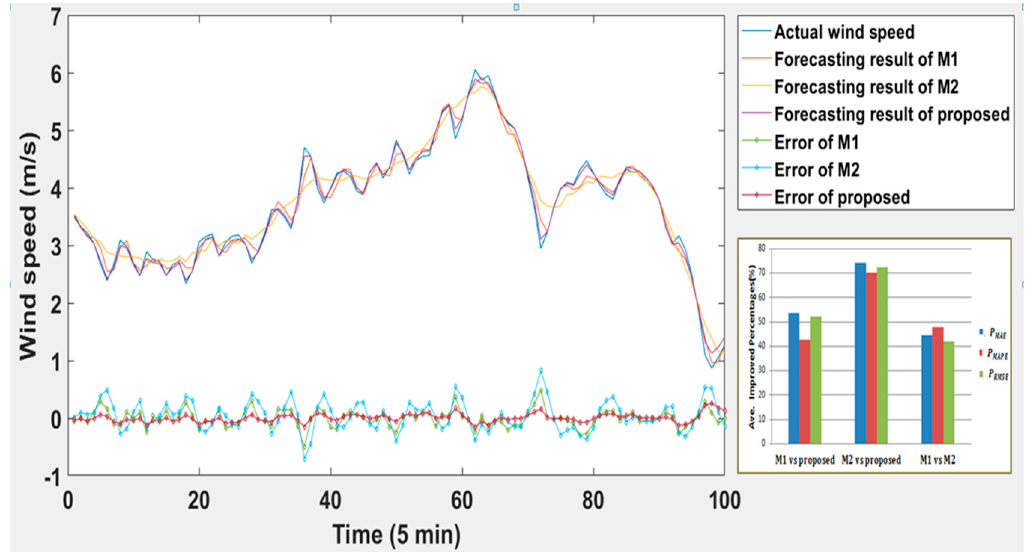
Figure 9. Comparison between separate prediction models and proposed prediction model.